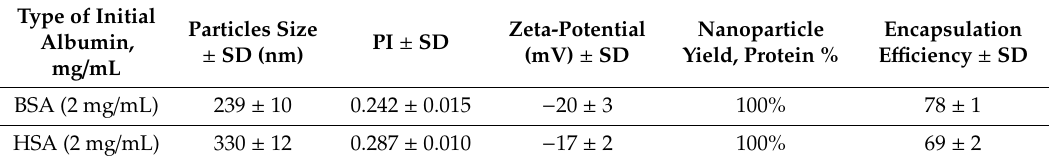
Table 2. Characteristics of HSA- and BSA-derived nanoparticles containing HU incorporated using inclusion